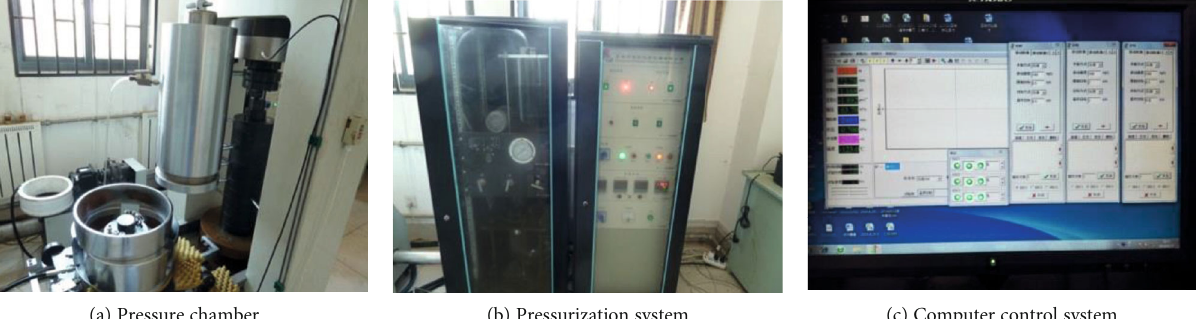
Figure 5: TAW-2000M rock triaxial servo